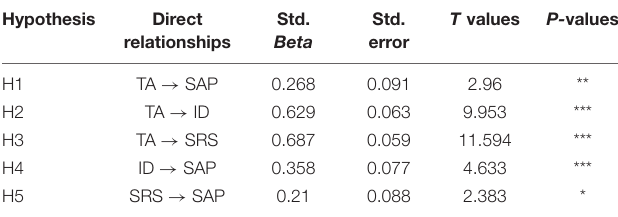
TABLE 5 | Hypotheses testing direct effect.